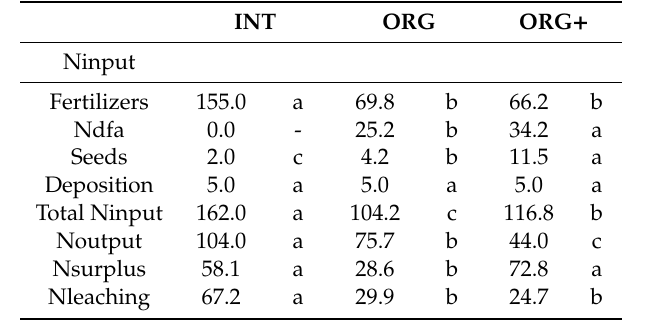
Table 1. Annual mean values (2-crop and 4-year basis, kg N ha − 1 yr − 1 ) of Nitrogen inputs (Ninput),